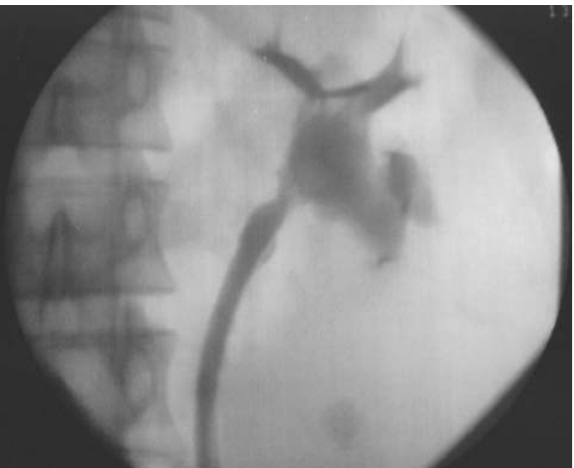
Figure 4 – Retrograde ureterography showing opacification of the proximal part of the collecting system with a narrow segment at the site of previous obstruction.